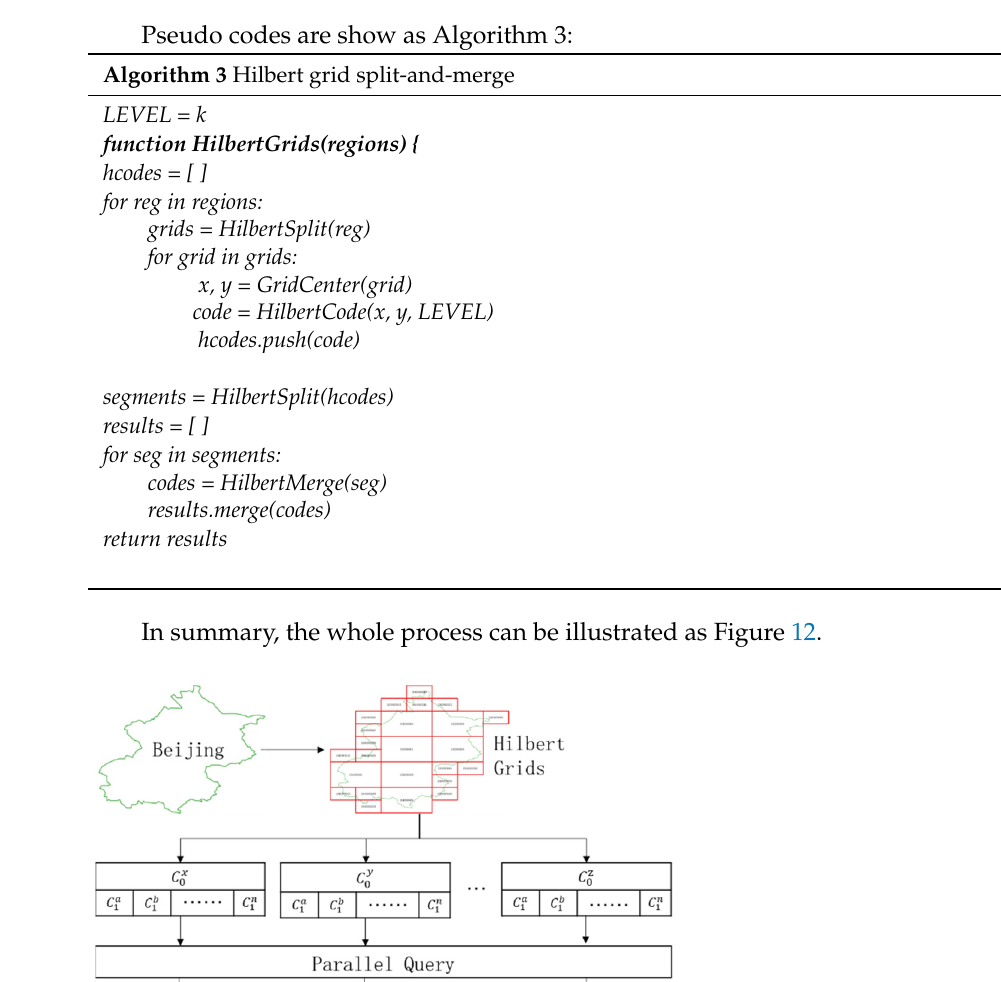
Figure 11. Process of grids merges according to Hilbert curve.